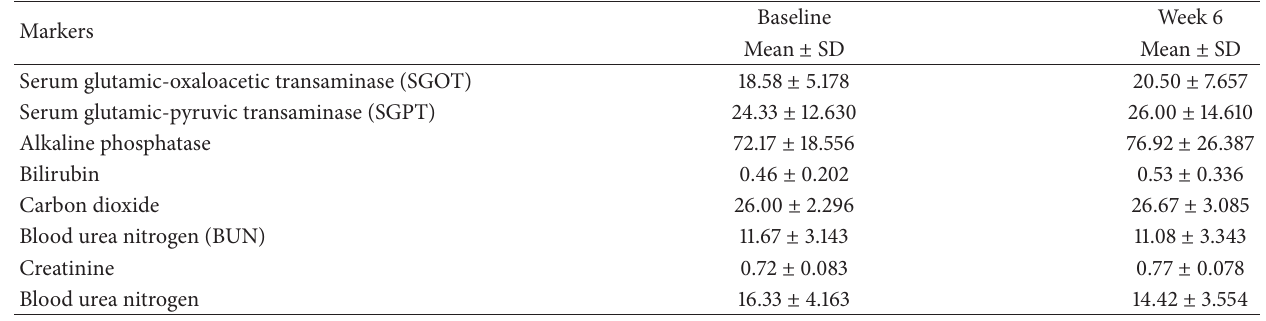
Table 4: Serum markers for liver, lung, and kidney